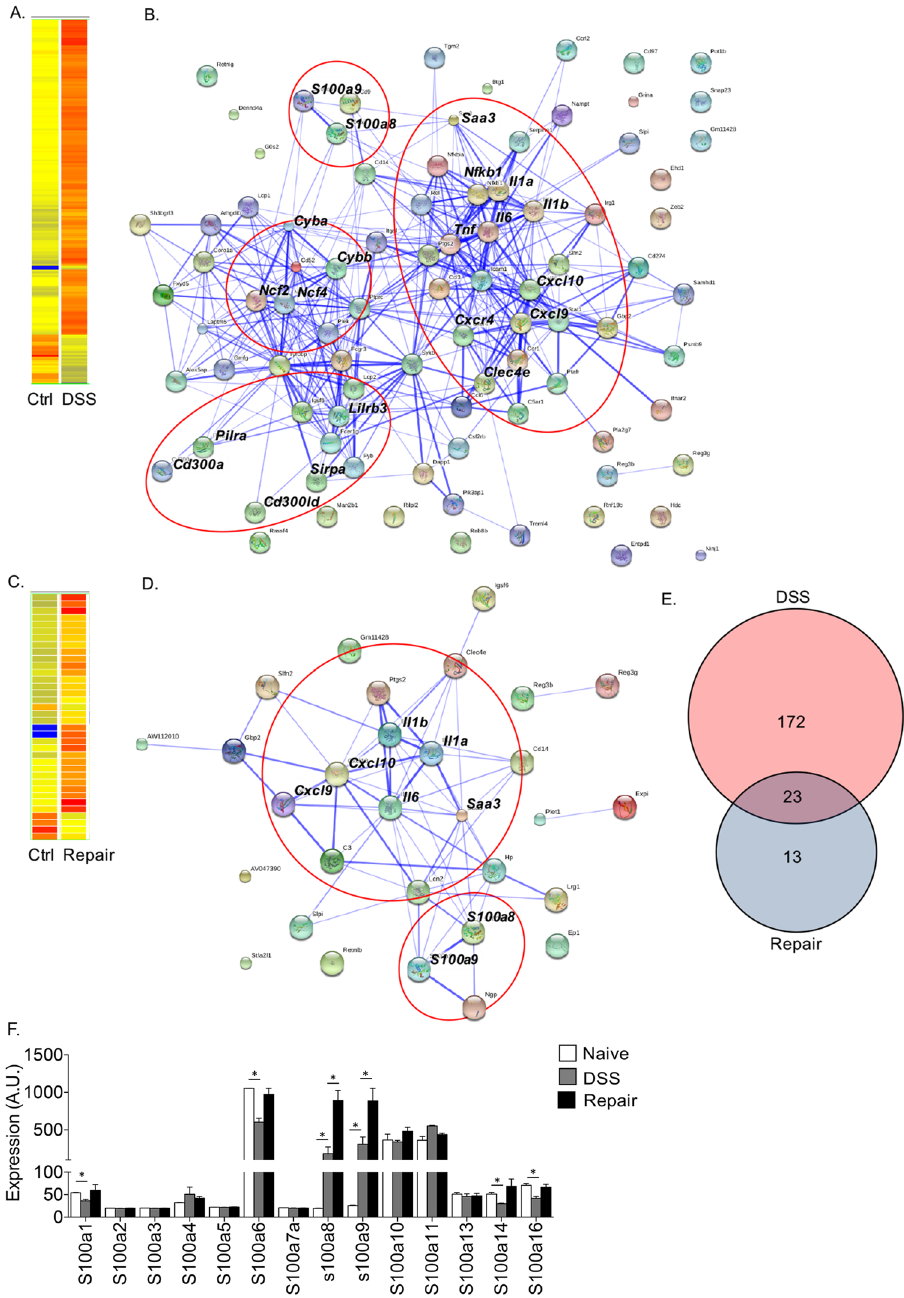
Figure 3. Microarray analysis of eosinophils during inflammation and repair. Colonic eosinophils were isolated from control (Ctrl) mice, and mice during the inflammatory (DSS) and healing (Repair) stages. Heat map ( A,C ) and STRING ( B,D ) analyses of genes that were significantly up-regulated (p < 0.05 and fold-change > 2, respectively) in eosinophils during the inflammatory stage ( A,B ) and tissue-repair stages ( C,D ). In ( E ), Venn diagram of the altered genes is shown. Relative expression of all s100a transcripts, which were identified in eosinophils following microarray analysis. The relative expression (as obtained from the microarray analysis) of transcripts encoding different s100a family members in eosinophils is shown ( F ); In ( F ), data are from n = 2 (each group consisting of eosinophils that were sorted from 5-10 mice); A.U – arbitrary units, * p <